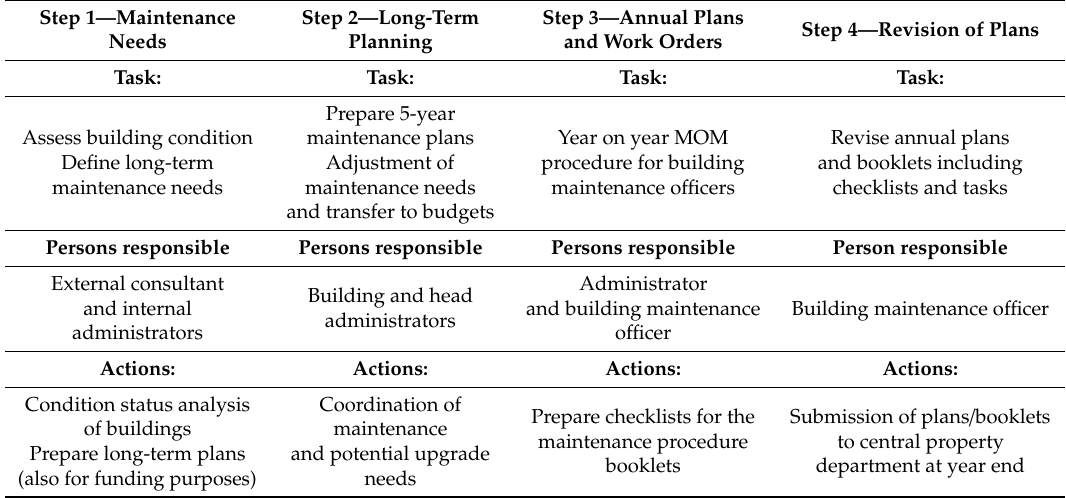
Table 5. Stepwise procedure for the management of MOM needs and tasks as exercised by the municipality in this case